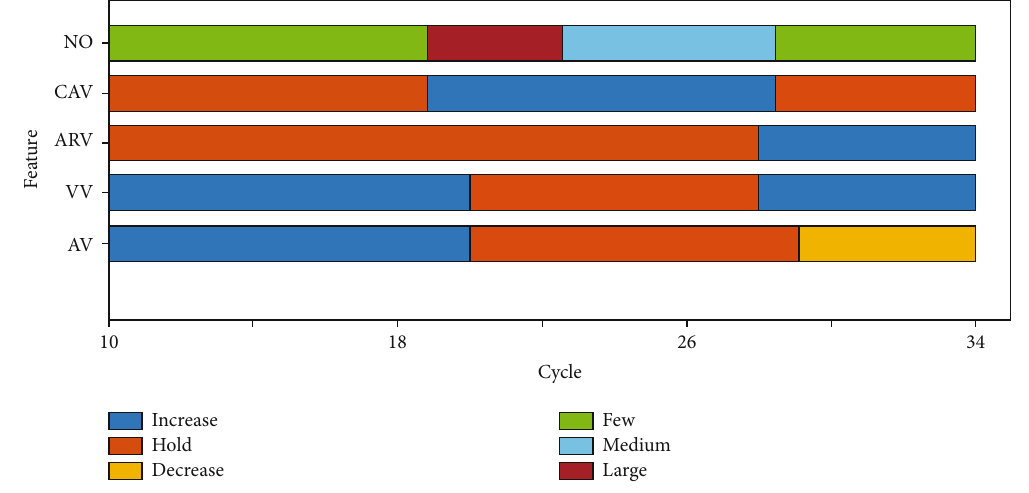
Figure 11: Schematic diagram of feature change of